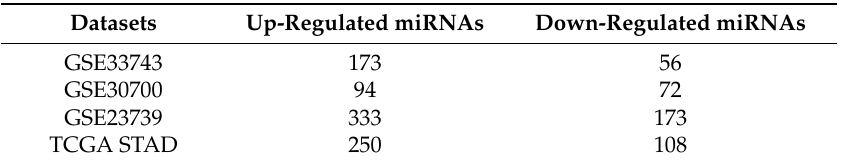
Table 1. Differentially expressed miRNAs from GEO and TCGA STAD